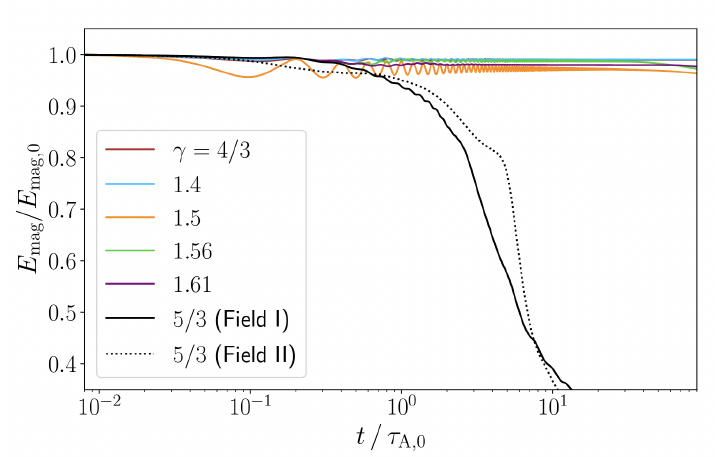
Figure 2. Magnetic energy as a fraction of its initial value over Alfvén time scales. The polytropic index γ = dln P /dln ρ is varied. In a barotropic case, it equals the adiabatic exponent, γ = Γ = 5/3. The magnetic energy declines without reaching a stable configuration in this case, from